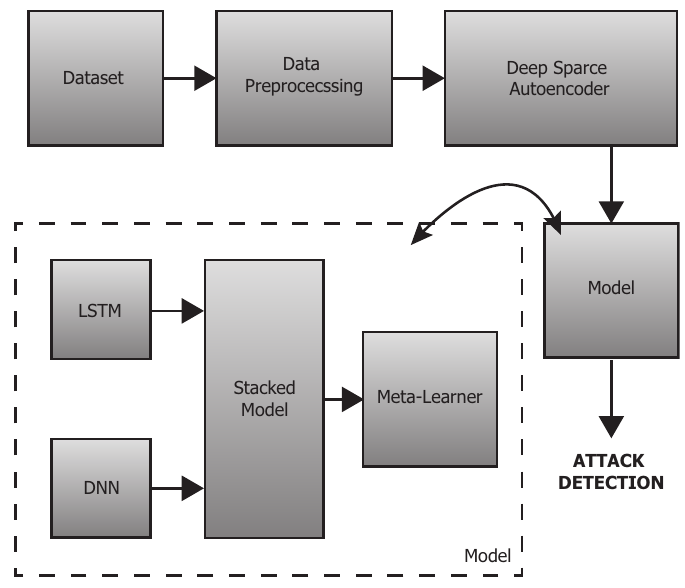
Figure 1. The scheme of the proposed anomaly detection